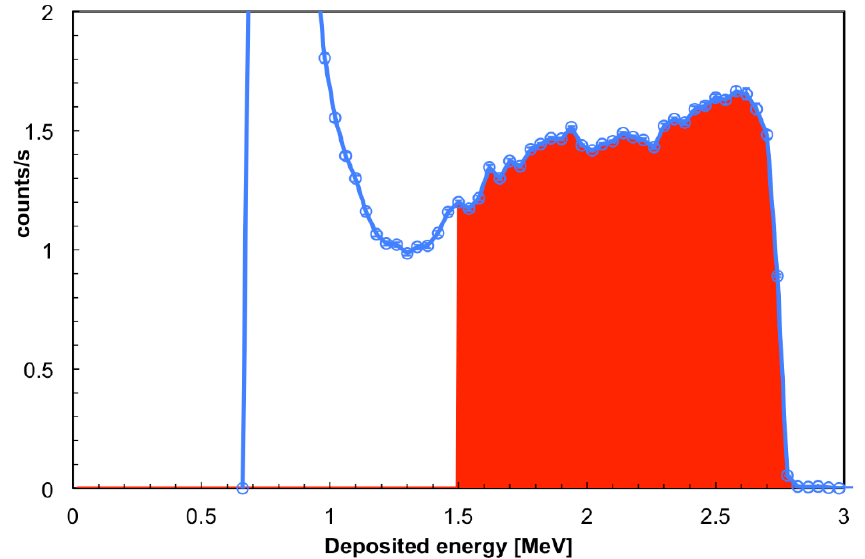
Figure 16. The typical deposited energy spectrum collected in the inside position with the SiLiF detectors under test. The colored area represents the number of detected neutrons for the chosen 1.5 MeV energy threshold, and was normalized to the impinging flux to provide the detection efficiency for the chosen threshold.